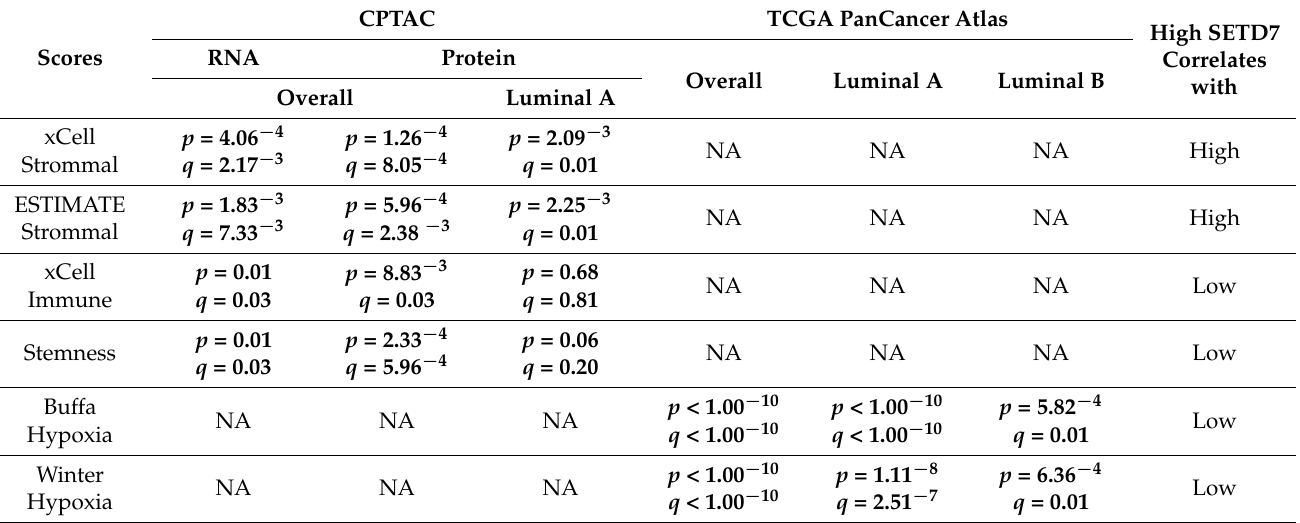
Table 2. SETD7 association with stromal, immune, stemness and hypoxia scores. Significant values are highlighted in bold: Wilcoxon test p -value and Benjamini–Hochberg FDR correction q -value. NA—not